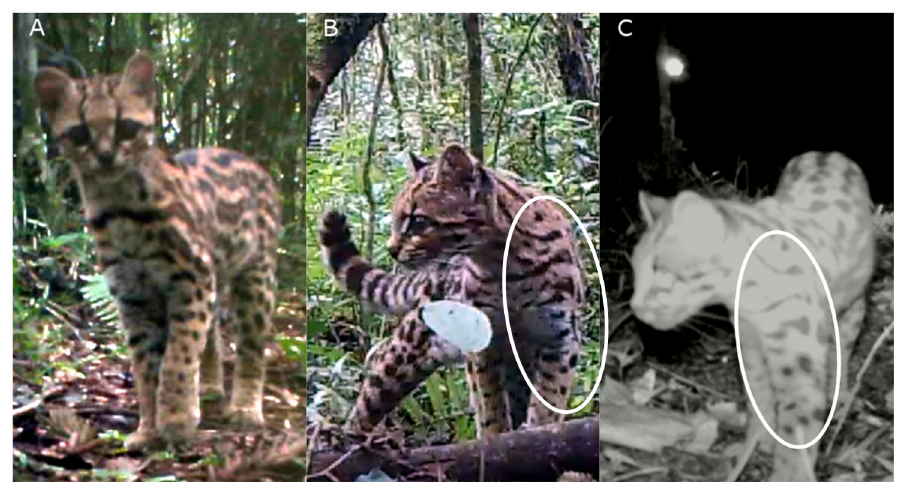
Fig 2. Approach for individual margay identification. A and B are photographs of two different individuals. B and C photographs of the same individual recorded on separate occasions. Individual identification is based on the unique coat pattern on the front right leg and neck (white